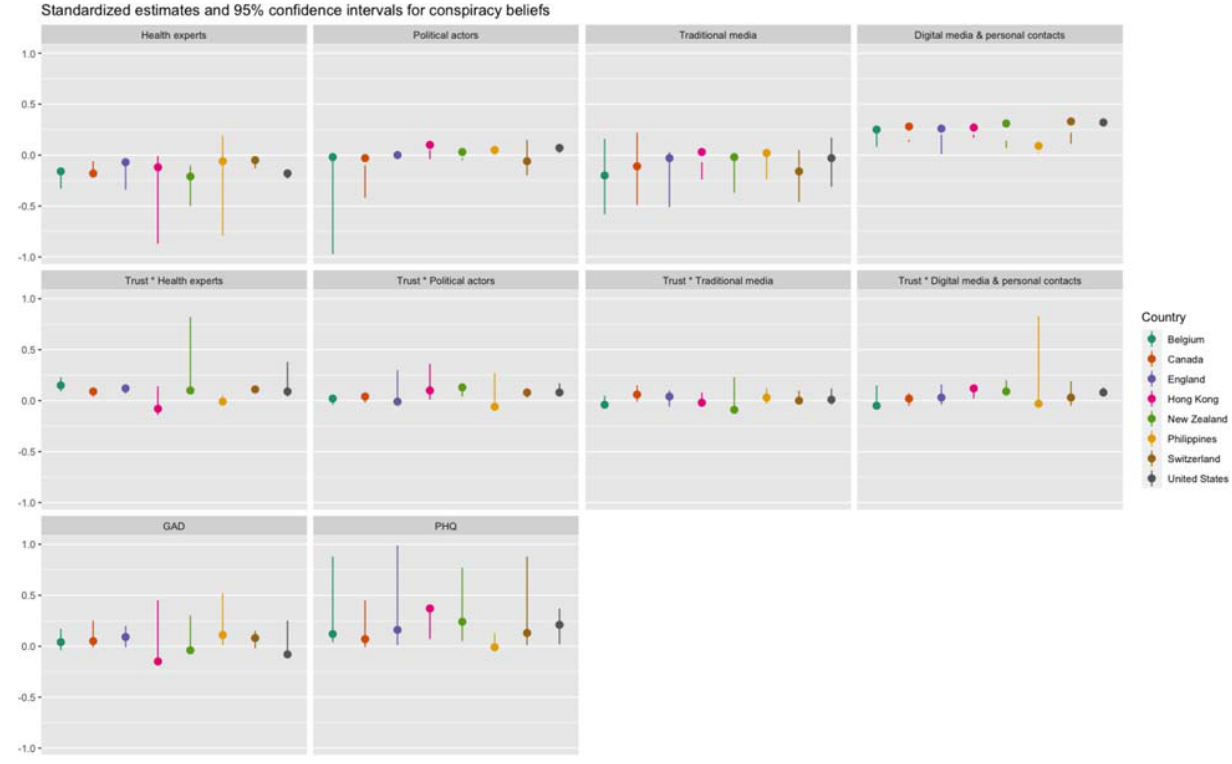
FIGURE 1 | Direct standardized effects of predictors on conspiracy beliefs per